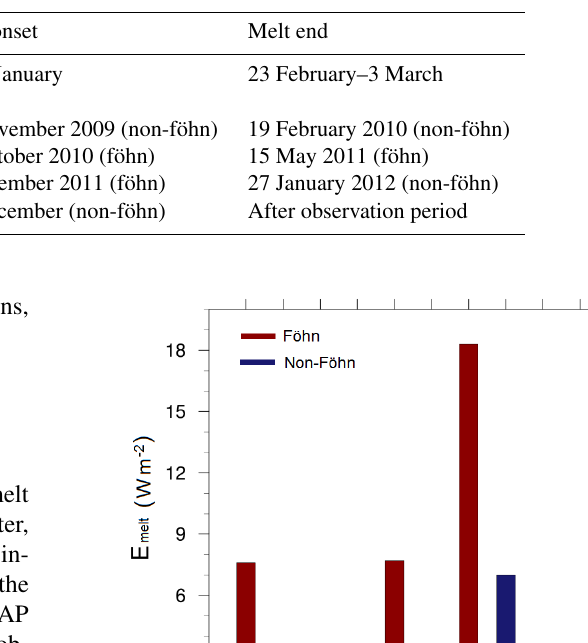
Table 6. Melt onset and end dates. Melt onset refers to the first day with observed melting. Melt end is the last day of the melt season on which melt is observed. Dates are taken from AWS2 to allow comparison with Luckman et al. (2014) melt onset and end dates. A range of values are given due to the uncertainty of reading Fig. 2 from Luckman et al. (2014) and are not the variation in dates.